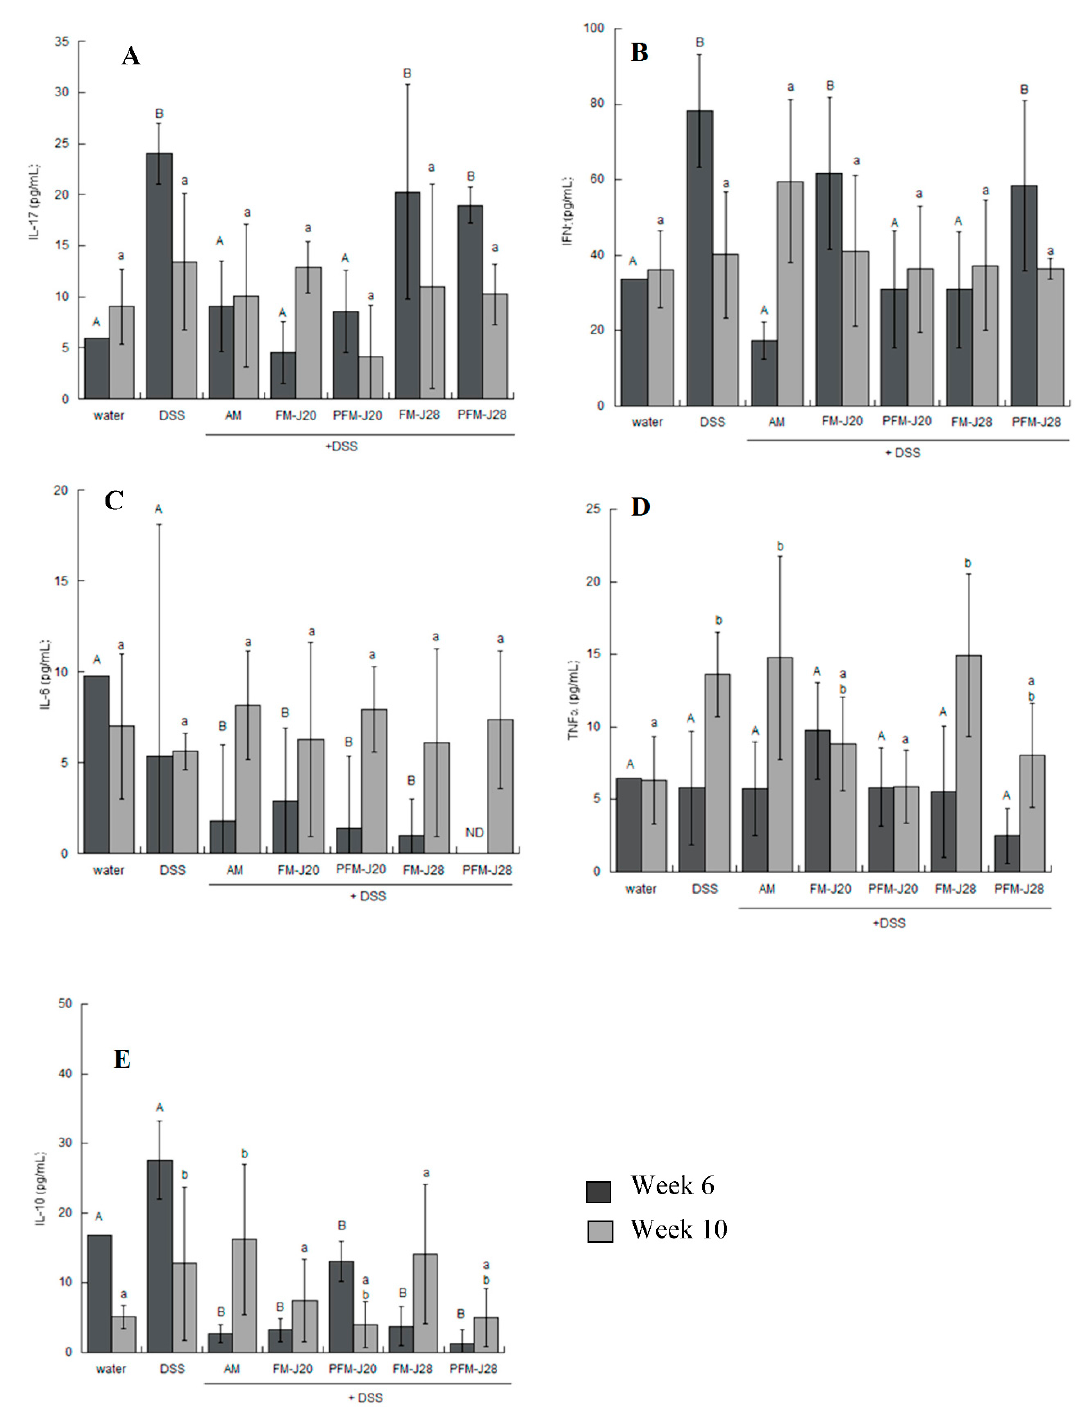
Figure 3. Effects of DSS and fermented milk administration on: IL-17 ( A ); and IFN γ ( B ) in serum samples, determined by ELISA; and on: IL-6 ( C ); TNF α ( D ); and IL-10 ( E ), determined by flow cytometry at Weeks 6 and 10. Bars with an uppercase letter indicate statistical differences at Week 6 among treatments, and bars with a lowercase letter indicate statistical differences at Week 10 ( p < 0.05) according to the Kruskal–Wallis test. The values correspond to medians ± interquartile ranges for n = 5.